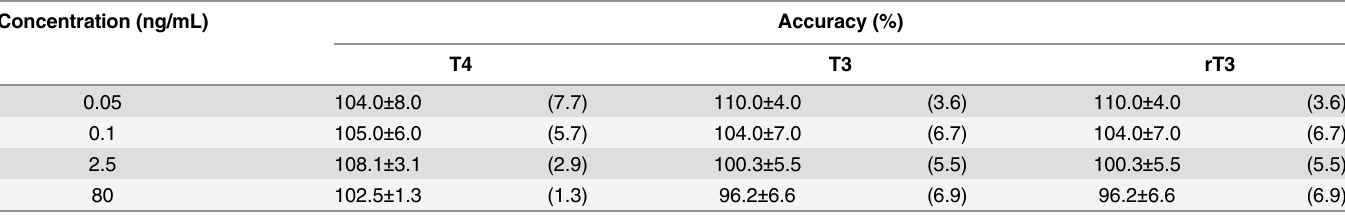
Table 2. Precision and Accuracy of intra-day assay. Concentration